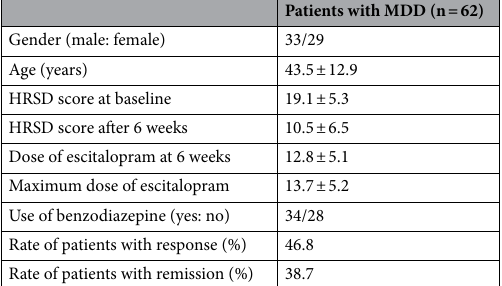
Table 2. Demographic and clinical characteristics of the patients with major depressive disorder (MDD).